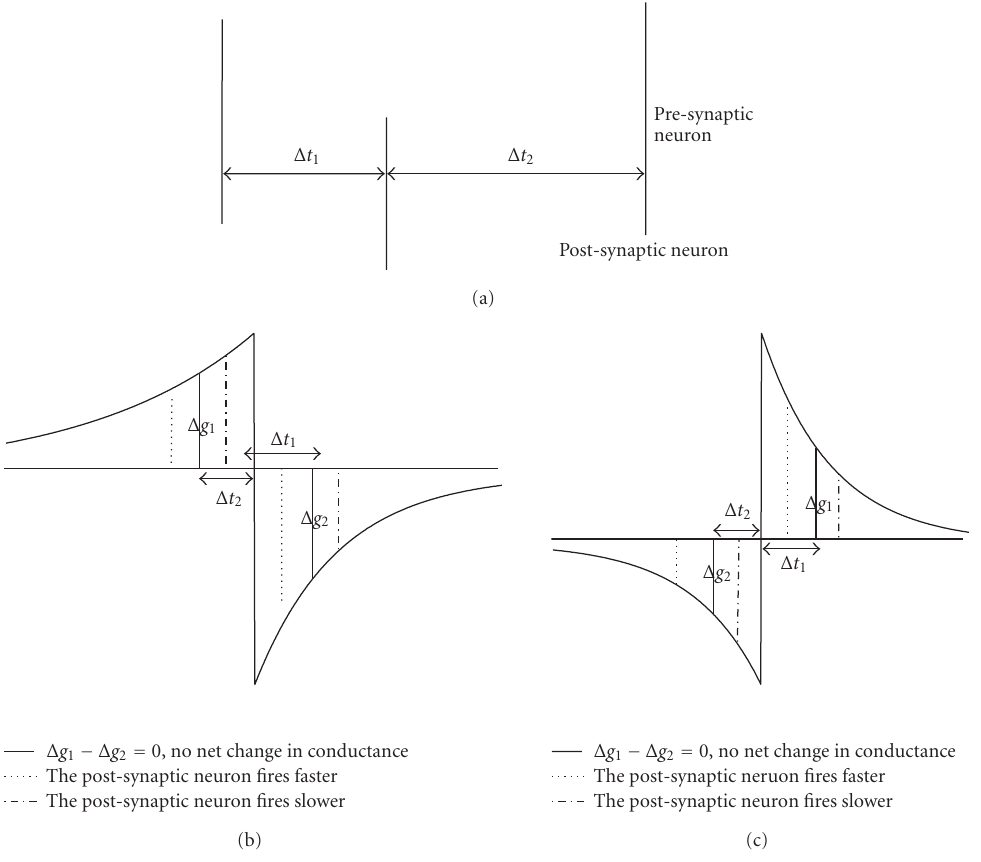
Figure 8: Di ff erent synchronization mechanisms for di ff erent STDP rules. (a) Shows the situation of Δ t 1 − Δ t 2 = T 1 = T 2 , where Δ g 1 − Δ g 2 = 0. The solid lines in (b) and (c) are same as (a). (b) and (c) present the change of synaptic strength of dc-aSTDP and dc-STDP rules,